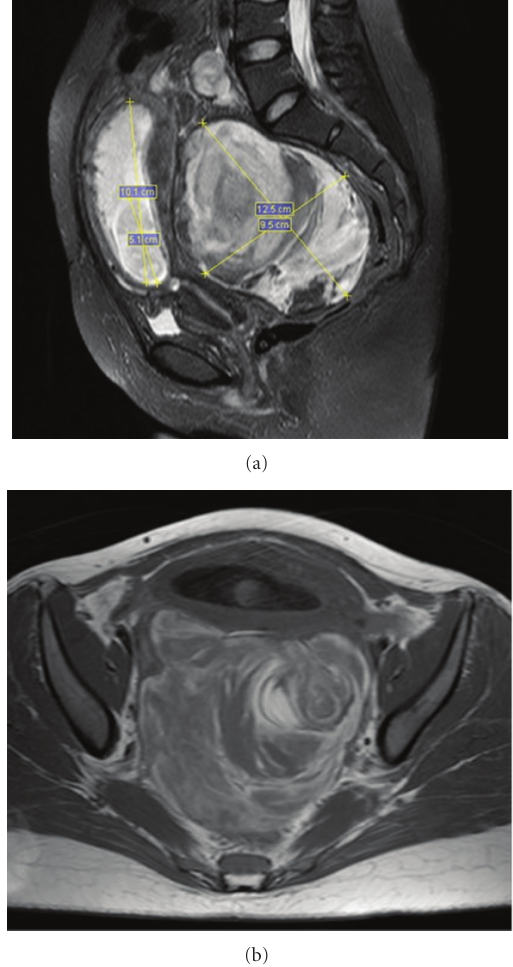
Figure 2: (a) T2-weighted sagittal sequence MRI, showing uterus with 12-week conception in the anterior region and a complex mass occupying the retrouterine region; (b) adnexal T2-weighted sequence MRI, showing large cystic mass with “onionskin” appear- ance, which might correspond to multiple episodes of organized bleeding. MRI: magnetic resonance